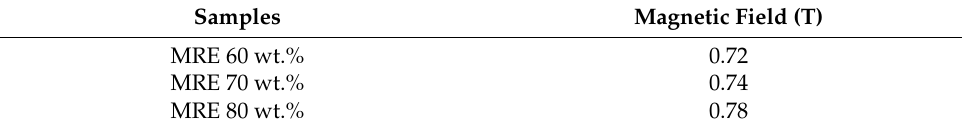
Table 3. Summary of the sensitivity of the MRE material to detect 0.01